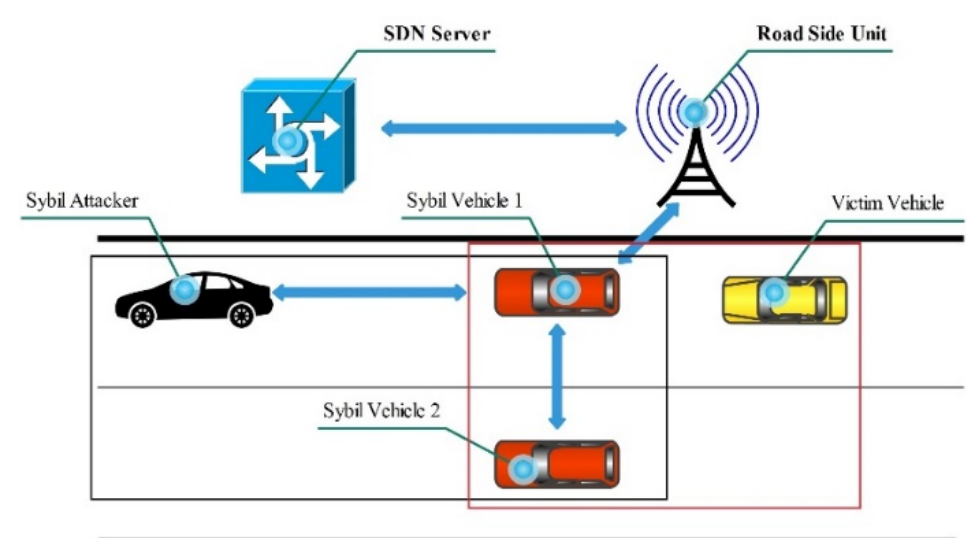
Figure 20. Sybil attack in SDN-based VANETs.